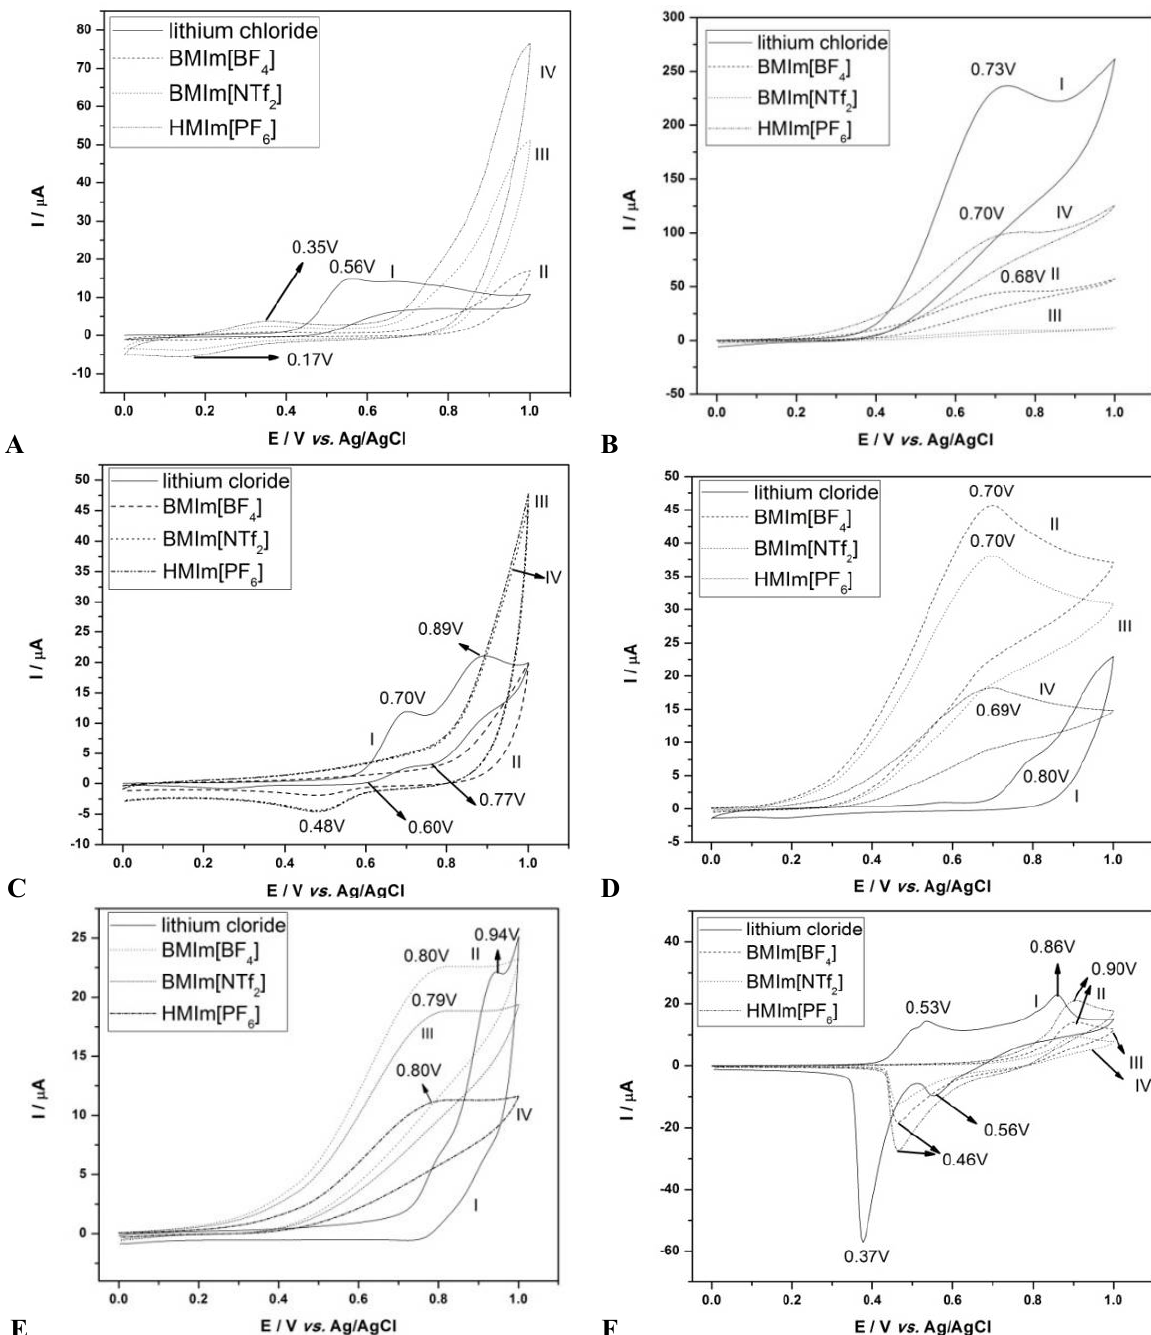
Figure 2. Cyclic voltammogram obtained for oxidation of 244 mg·L − 1 of amine in the ionic liquid BMIm[NTf ] at a glassy carbon electrode. Scan speed: 50 mV·s − 1 . ( A ) 2,4- 2 diaminotoluidine; ( B ) 2-chloro-4-nitroaniline; ( C ) 2-methoxy-5-methylaniline; ( D ) 2- naphtylamine; ( E ) 3,3'-dichlorobenzidine; ( F ) 3,3'-dimethylbenzidine; ( G ) 4,4'-diamino- diphenylmethane; ( H ) 4,4'-methylene-bis-chloroaniline; ( I ) 4,4'-oxydianiline; ( J ) 4-amino- biphenyl; ( K ) 4-chloroaniline; ( L ) aniline; ( M ) benzidine; ( N ) o -anisidine; ( O ) o -toluidine in methanol/BMIm[BF ] (50:50 v/v); (III) amine + methanol/BMIm[NTf 4